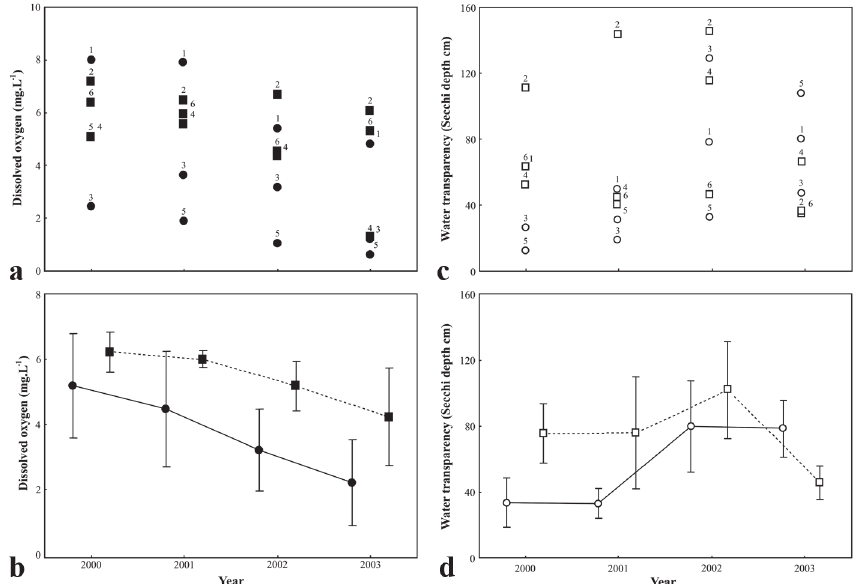
Fig. 3. Interannual variation of the absolute and mean ± s.e. values of dissolved oxygen (a, c) and water transparency (b, d) in lakes (circle) and river channels (square) of the upper Paraná River floodplain, in years of short (2000 and 2001) and moderate (2002 and 2003) floods. Numbers 1-6 are codes of the sampling stations (see Fig. 1).